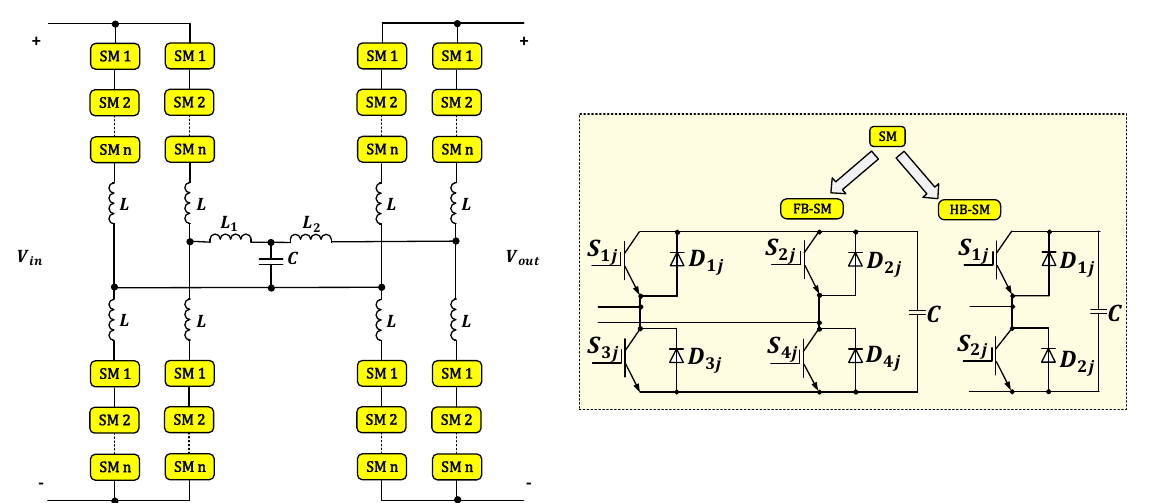
Figure 10. MMC-LCL converter circuit diagram.